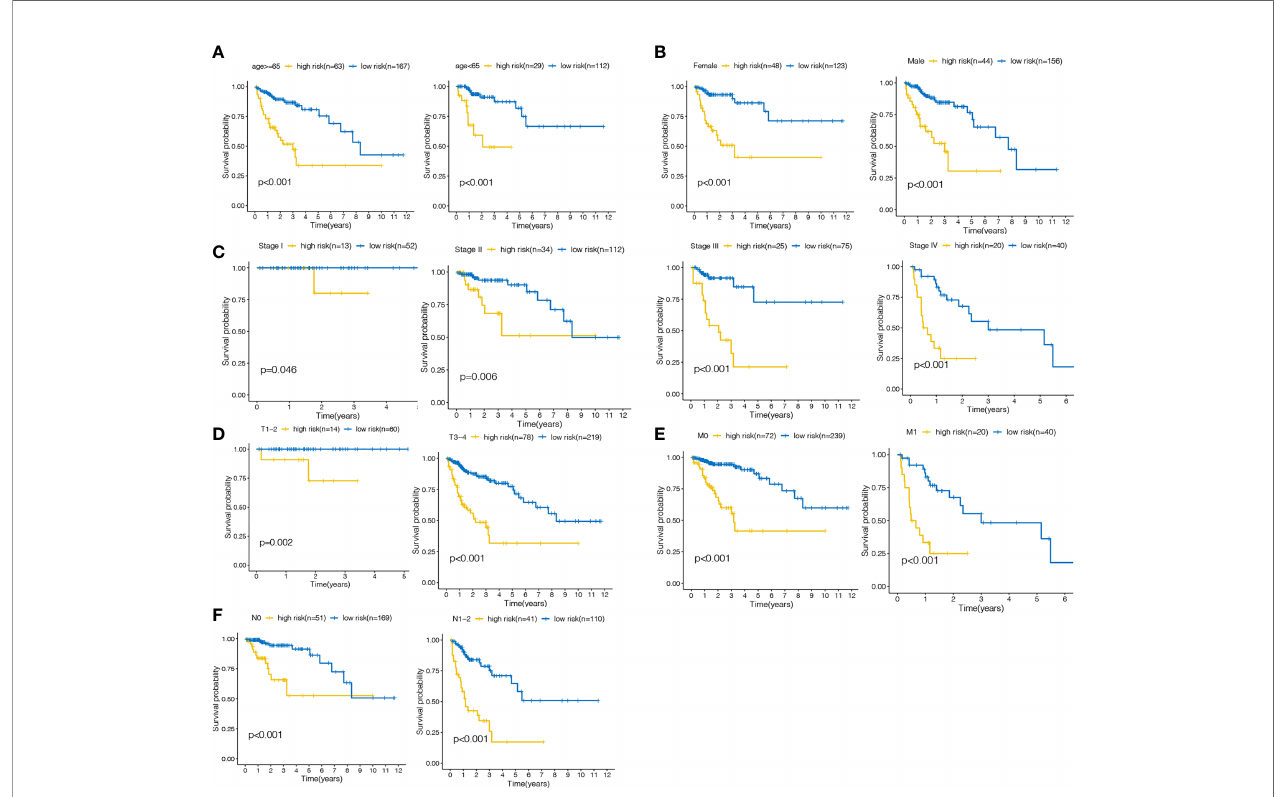
FIGURE 5 | The survival curves of the lalncRNA pairs signature concerning each strata of age, gender, TNM stage. (A) ≥ 65 years, <65years (B) Female, male (C) stage I, II, III, IV (D) T1-2, T3-4 (E) M0,M1 (F)